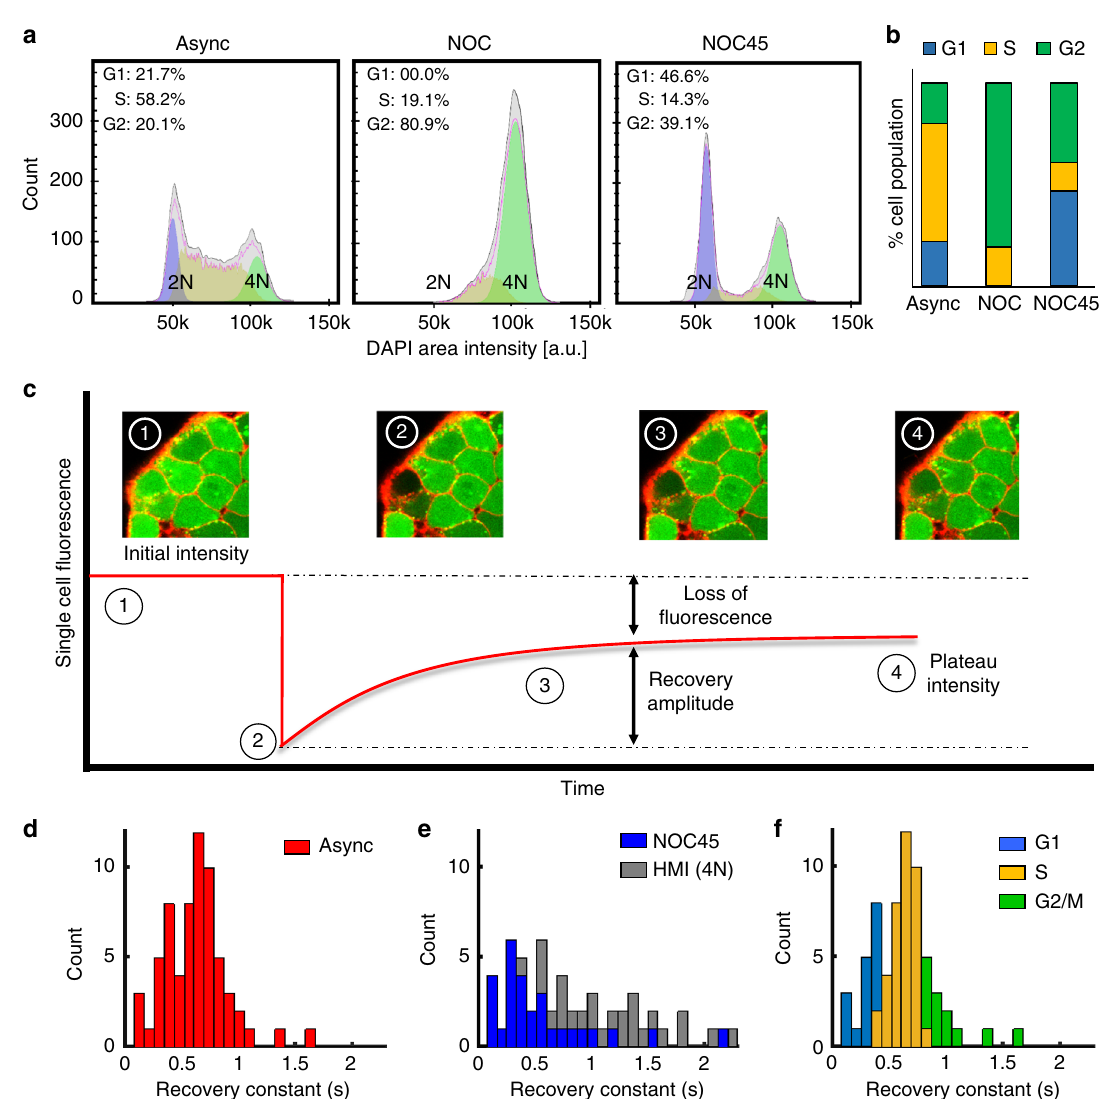
Fig. 3 Analysis of intercellular transport rates as a function of cell-cycle state. a Asynchronous cell population (Async) shifted to G2-phase after nocodazole treatment (NOC), and after 45 min of recovery (NOC45) the population shifted to G1-phase. b The population distribution averages from a were calculated for the Async, NOC, and NOC45 treatment conditions. c An illustration of the GAP-FRAP technique for quanti fi cation of relative diffusion rates between adjacent cells. d A histogram of recovery time constants collected using gap-FRAP in the Async population ( n = 64), where high and low recovery constants represent slow and fast transport rates, respectively. e The distributions of recovery constants for Hoechst-identi fi ed mitotic (HMI) cells ( n = 26) and NOC45 ( n = 28) were shifted to the right and left of the Async population, respectively, indicating slower and faster transport in these populations. f A projection of each cell cycle state onto the Async distribution using information from a and e , as described in Supplementary Figure